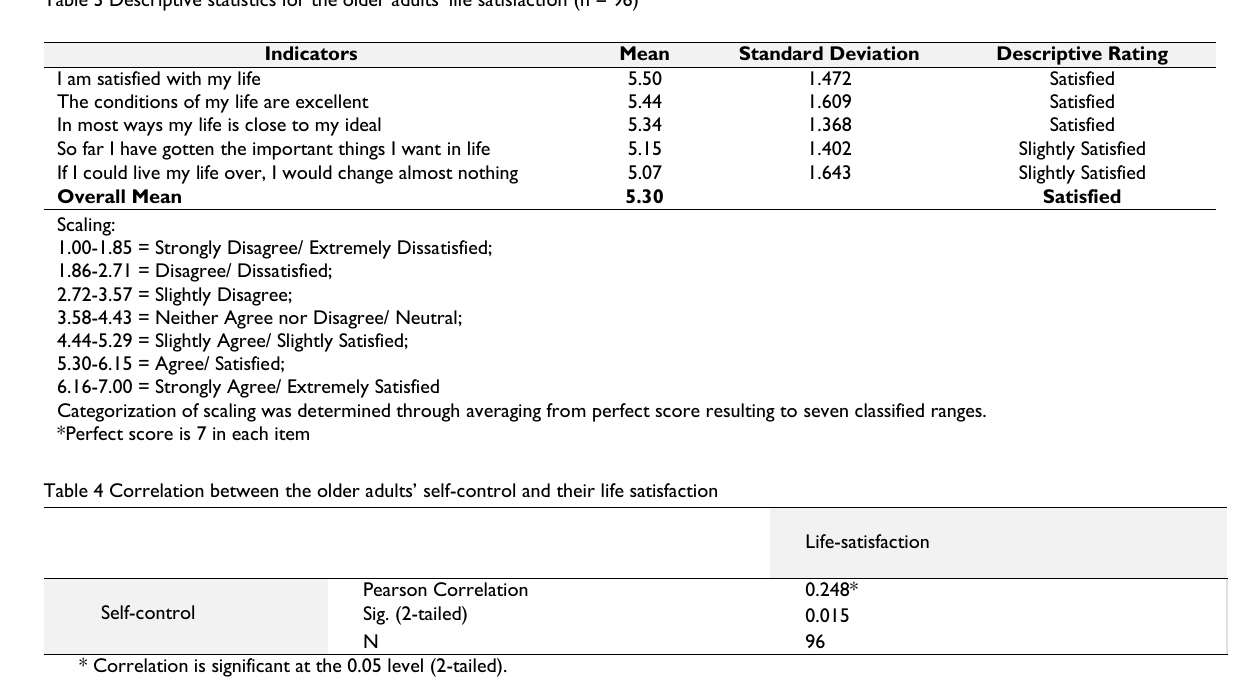
Table 3 D escriptive statistics for the older adults’ life satisfaction (n = 96)